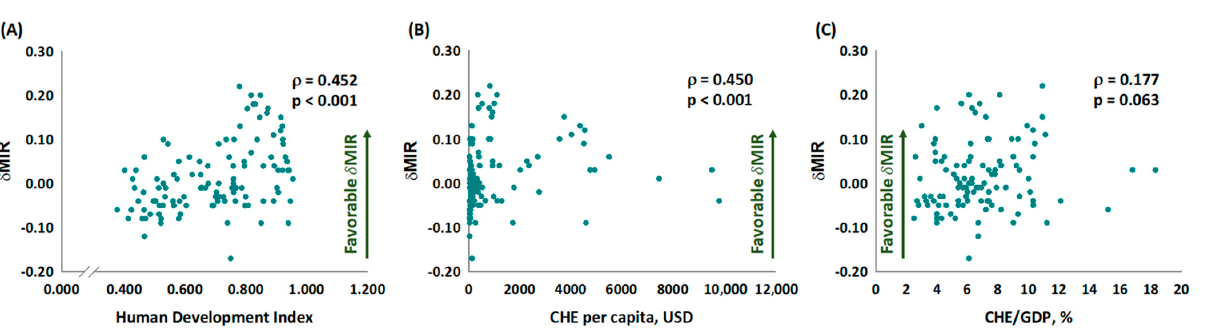
Figure 2. The ( A ) human development index, ( B ) current health expenditure per capita, and ( C ) current health expenditure as a percentage of gross domestic product are significantly associated with the mortality-to-incidence ratio in liver cancer.